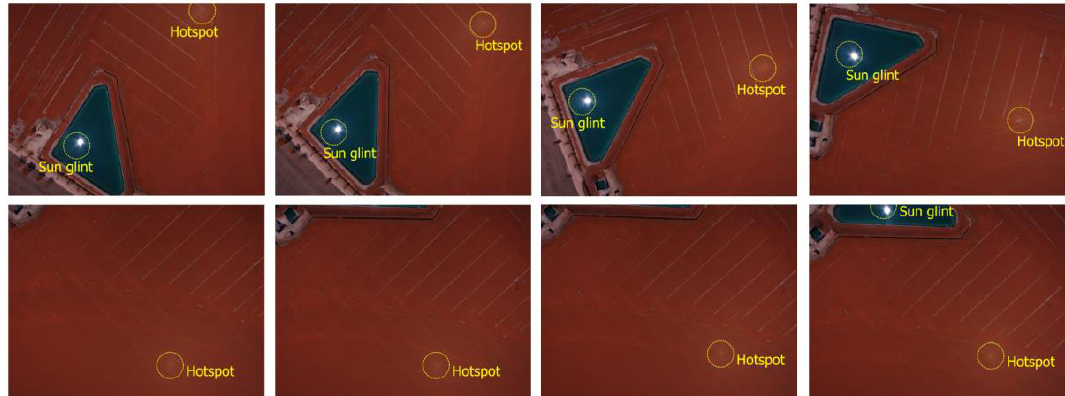
Figure 5. Hotspot and sun glint effects in the region of interest. It should be noted how the position of both effects varies through the different images.